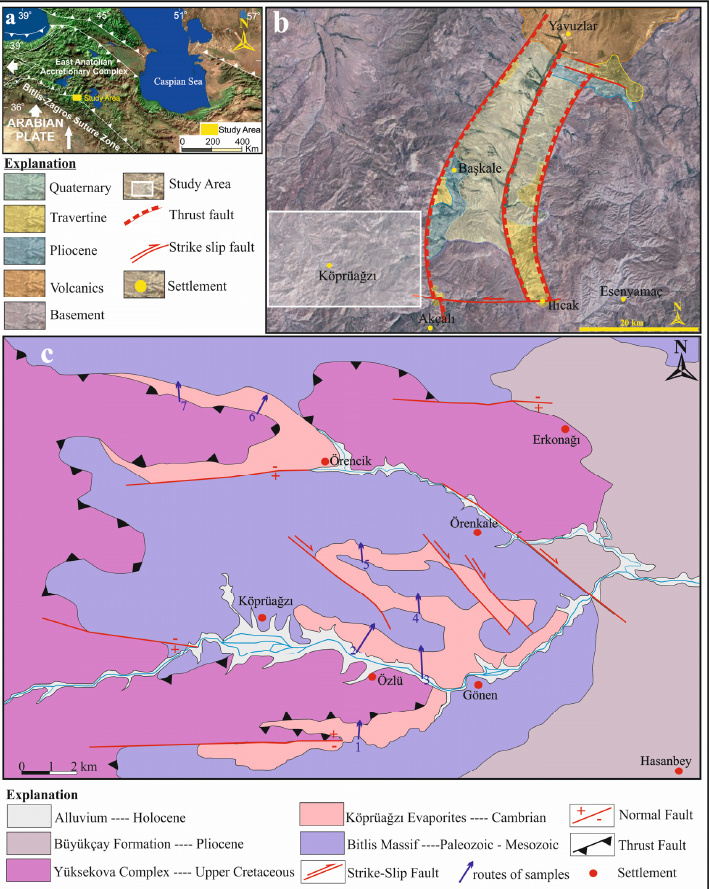
Figure 1. ( a ) Location of the study area in Eastern Anatolia, ( b ) location of the study area in the Ba ş kale Basin (modi fi ed from [13]). ( c ) Geological map and stratigraphy of the study area.